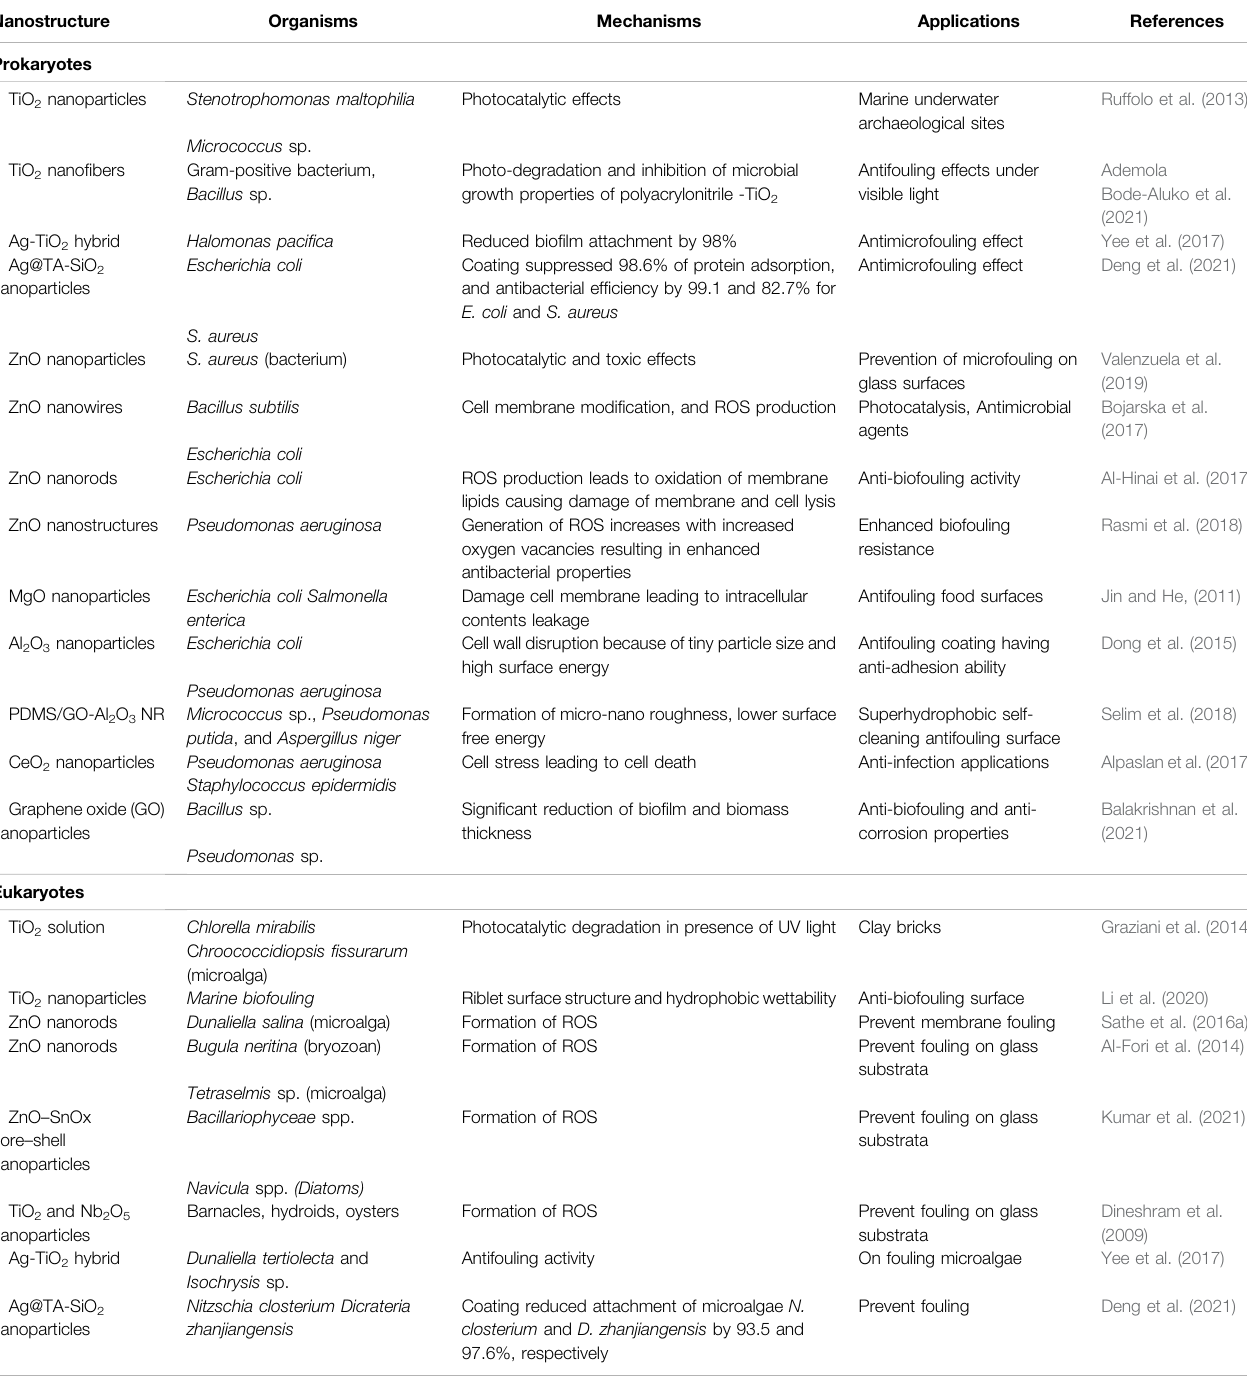
TABLE 1 | Antifouling properties of common metal oxide